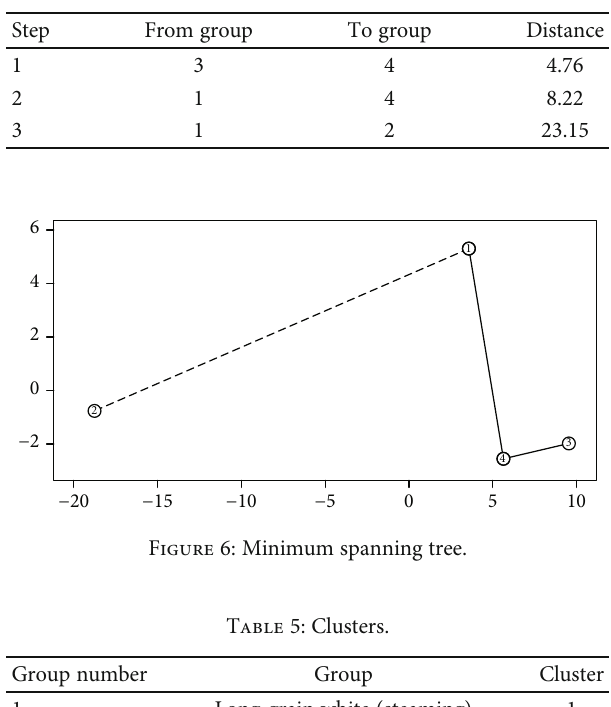
Table 4: Connections in the dendrite.